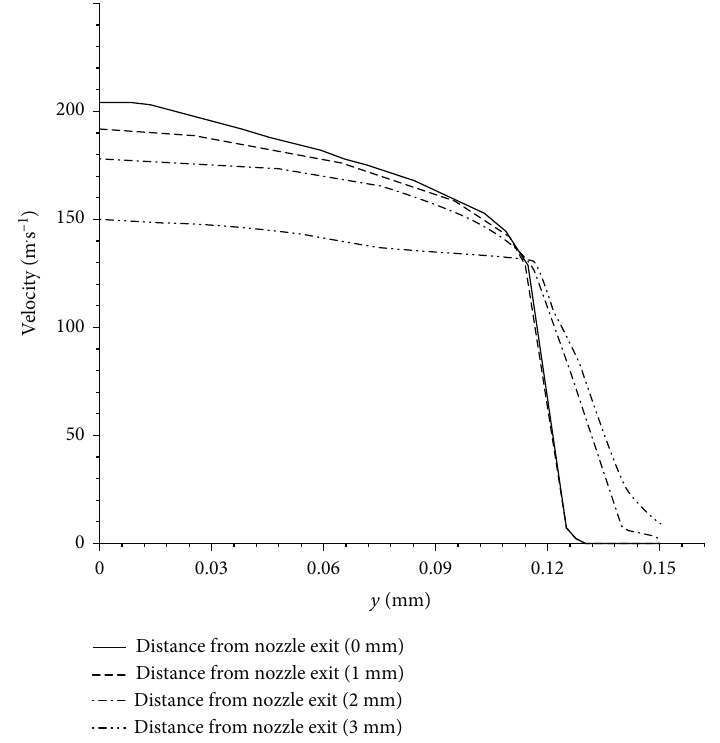
Figure 4: Comparison of velocity changes at di ff erent injection depths.